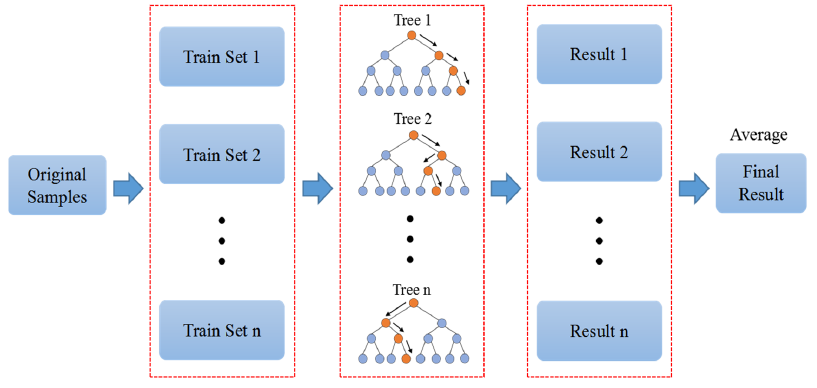
Figure 1. Flow chart of the random forest algorithm.